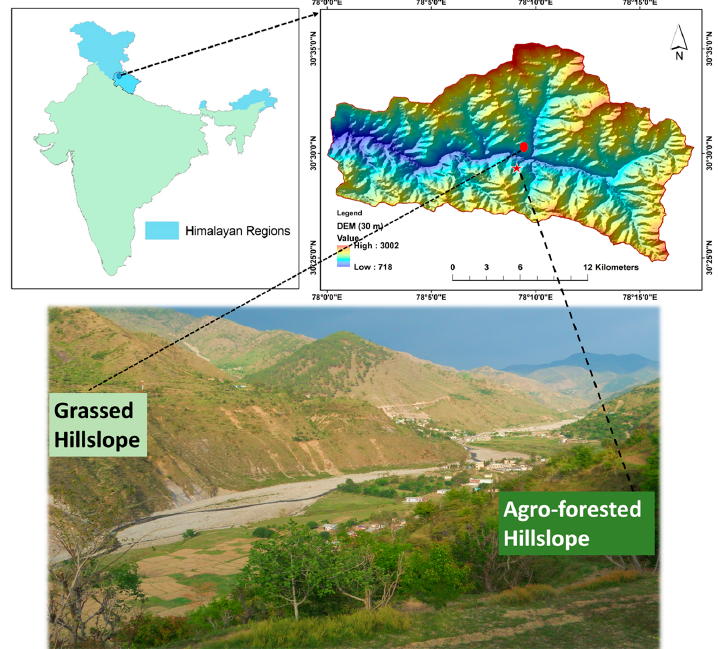
Figure 1. Location of Aglar watershed in map of India; both aspects of watershed showing the location of grassed (GA) and agro-forested (AgF) hillslopes in Digital Elevation Model (DEM) (reproduced from Figure 1 of Nanda et al. [29] with the copyright permission from Elsevier office).